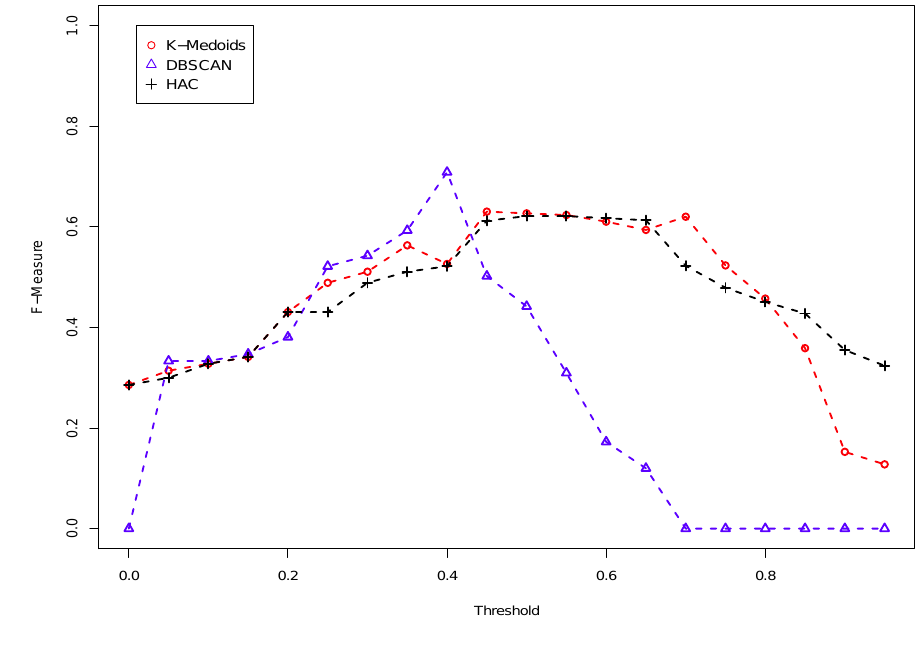
Figure 9. Clustering results using Jaccard